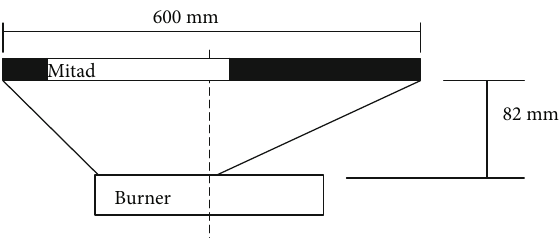
Figure 8: Flame height